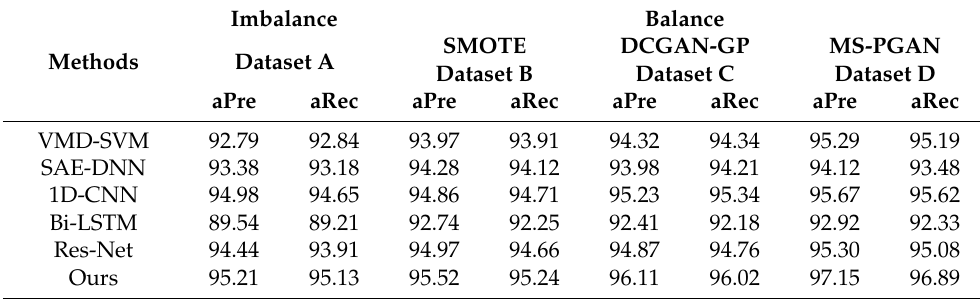
Table 8. The average precision and recall (%) of baselines and our proposed method for Case 1.